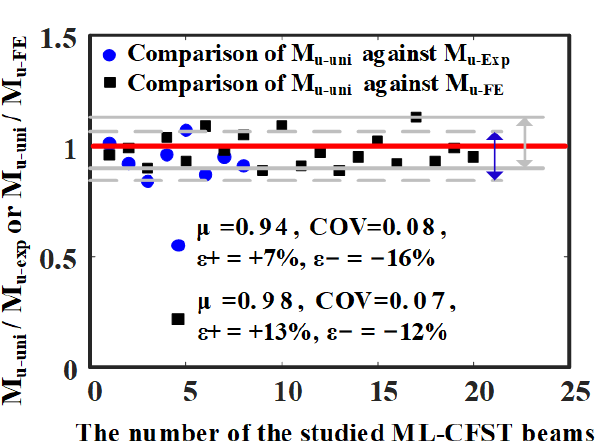
Figure 18. Comparison of the results predicted by the proposed approach against the experimental and numerical Table 2. Detailed results of M u − uni and M u − FE for the studied ML-CFST beams.